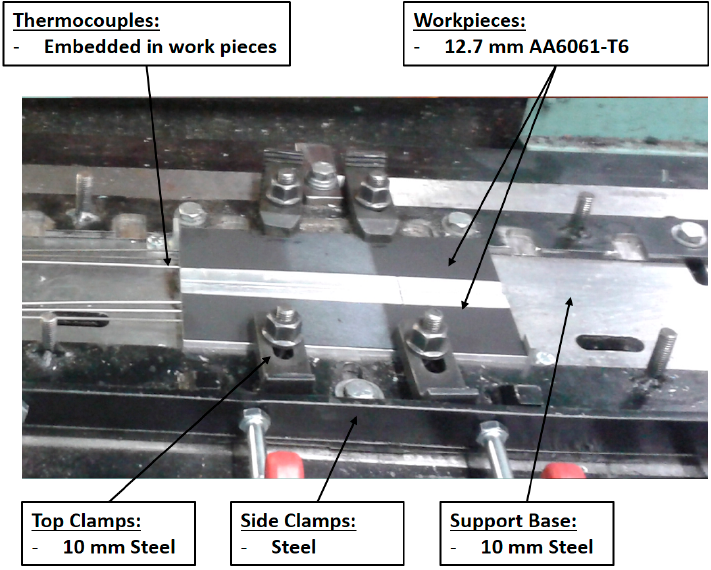
Table 7. Tool thermophysical properties.